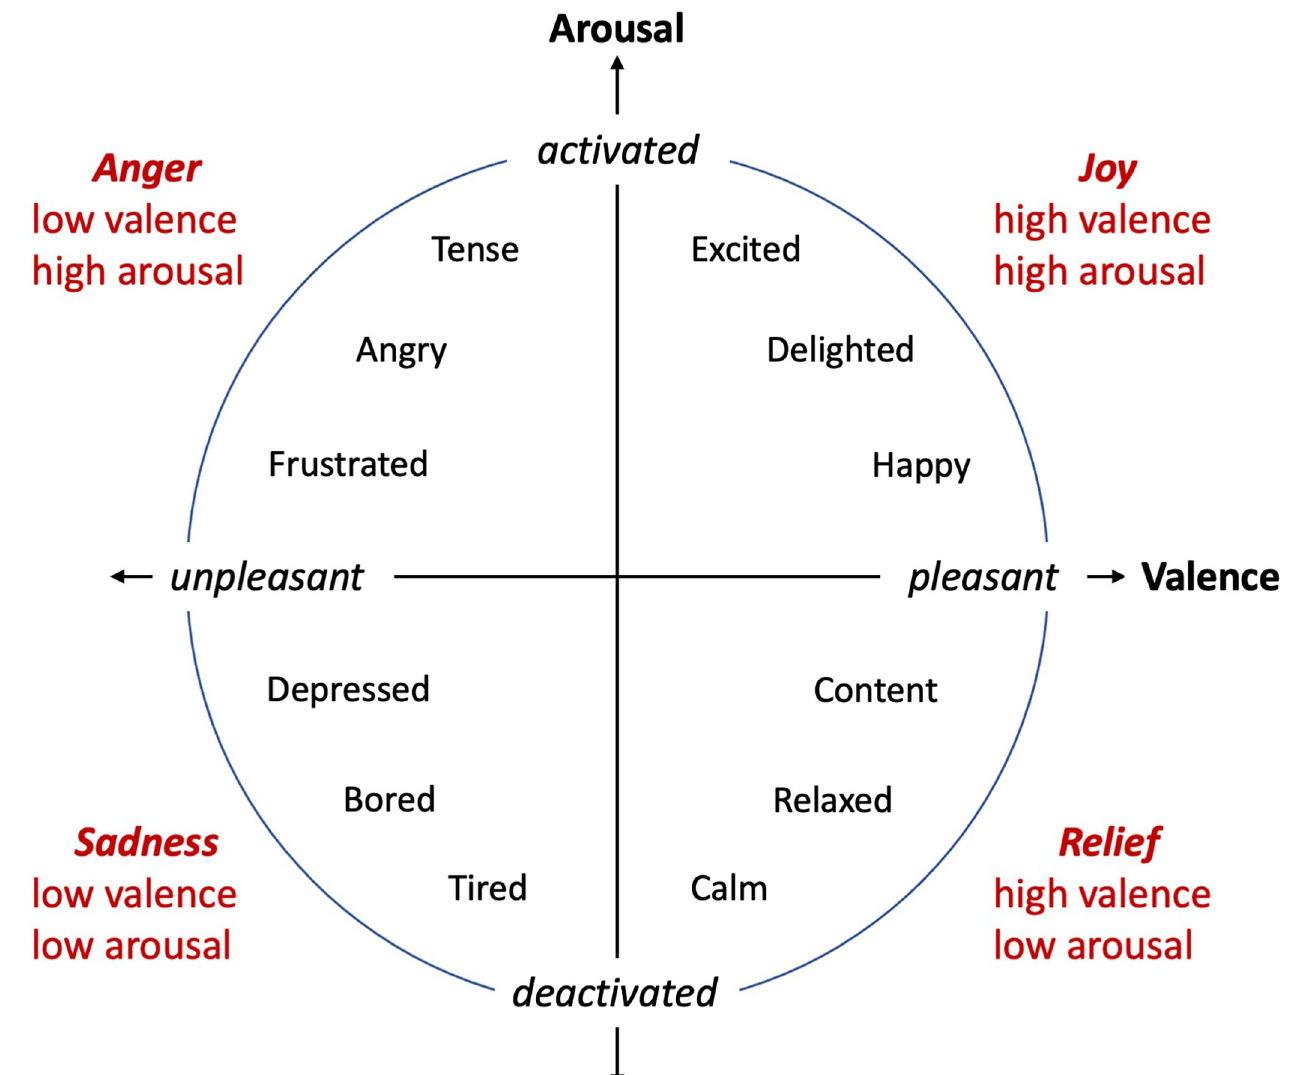
Fig 1. Model of emotion. Circumplex model of emotion [47] utilized as the model of emotions for the robot.